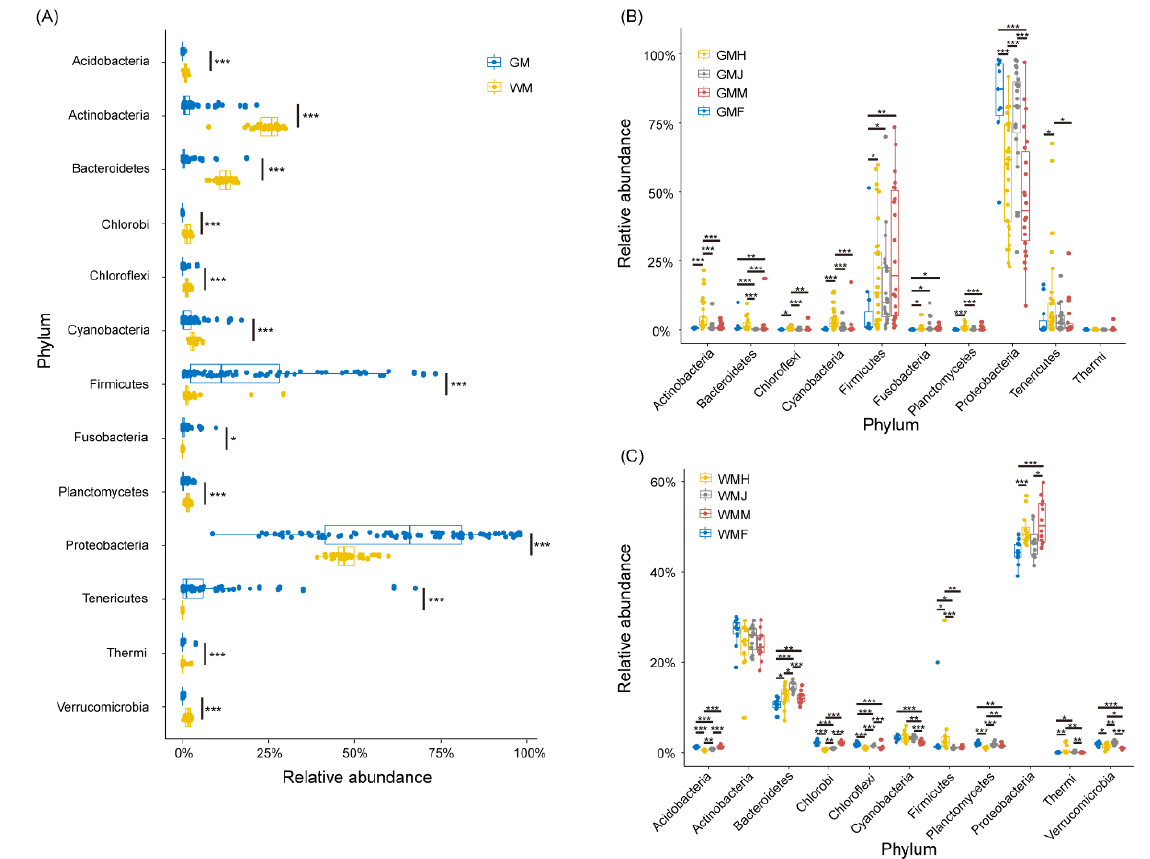
Figure 4. Phylum-level compositions of dominant water and Rhinogobio cylindricus gut microbiota. ( A ) Relative abundances of the dominant phyla of water and R. cylindricus gut microbiota. ( B ) Relative abundances of the dominant phyla of R. cylindricus gut microbiota among different sampling sites. ( C ) Relative abundances of the dominant phyla in the water microbiota among different sampling sites. GM, gut microbiota; WM, water microbiota; GMH, gut microbiota of R. cylindricus collected at Hejiang; GMJ, gut microbiota of R. cylindricus collected at Jiangjin; GMM, gut microbiota of R. cylindricus collected at Mudong; GMF, gut microbiota of R. cylindricus collected at Fengdu; WMH, water microbiota collected at Hejiang; WMJ, water microbiota collected at Jiangjin; WMM, water microbiota collected at Mudong; WMF, water microbiota collected at Fengdu. *, p < 0.05; **, p < 0.01; ***, p < 0.001.